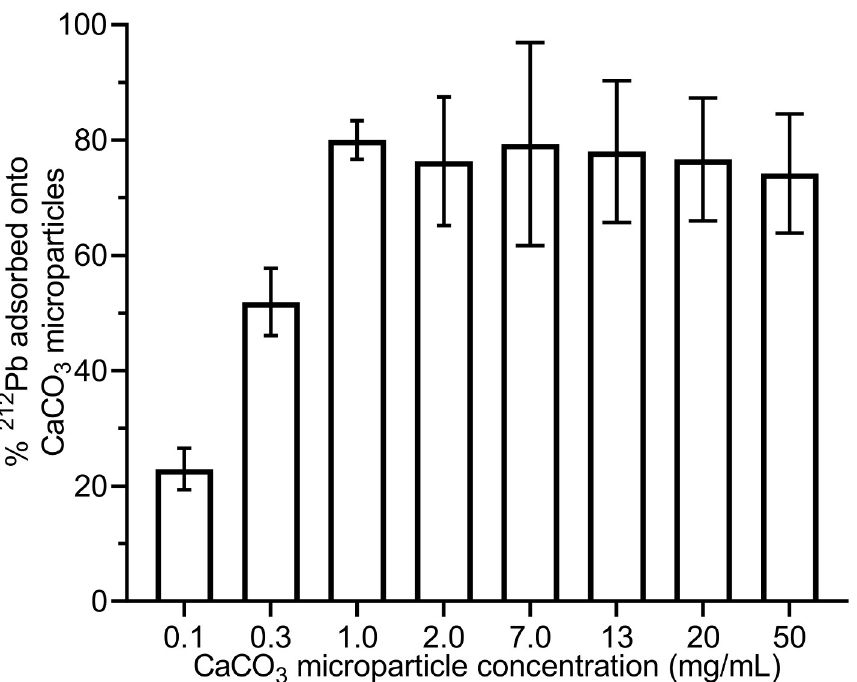
Fig 5. The percentage of 212 Pb activity adsorbed onto CaCO 3 microparticles at different CaCO 3 microparticle concentrations.